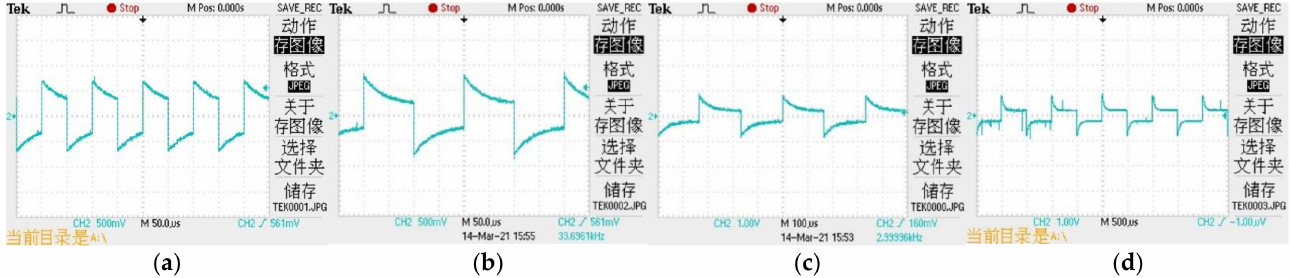
Figure 15. Waveforms at both ends of conductivity sensor under different frequency excitation signals: ( a ) 10 kHZ, ( b ) 5 kHZ, ( c ) 3 kHZ, and ( d ) 1